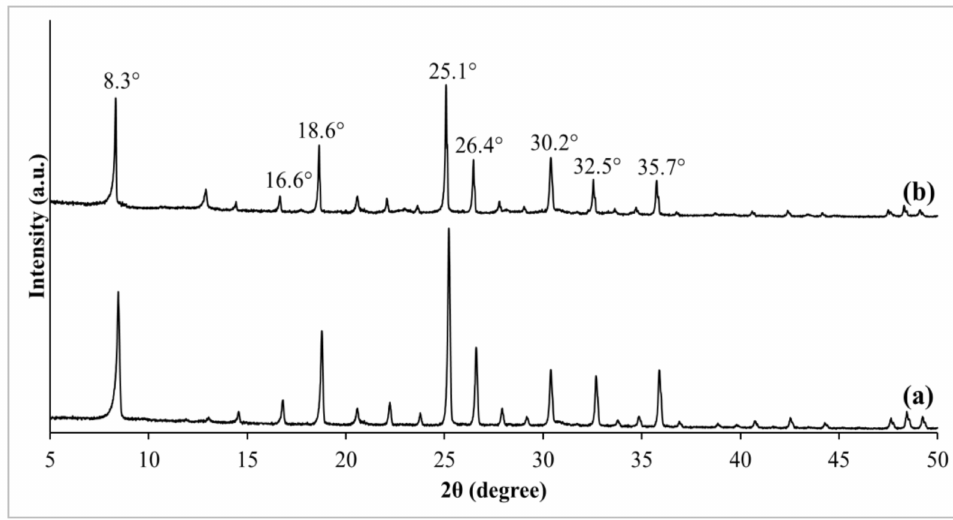
Figure 2. XRD patterns of (a) zeolite RHO and (b) zeolite NH 2